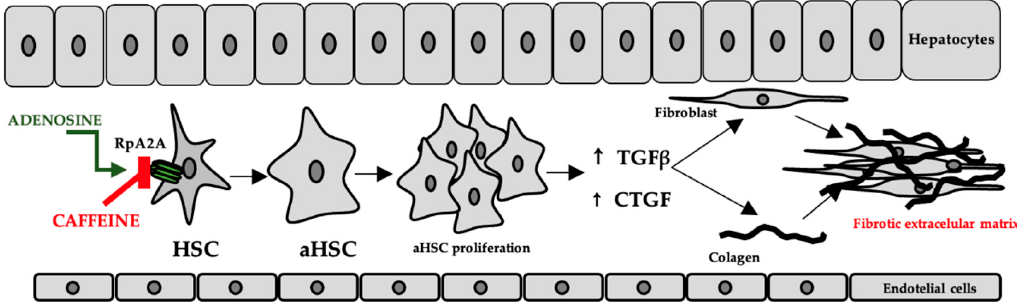
Figure 5. The role of adenosine and caffeine in the occurrence/prevention of liver fibrosis (HSC—hepatic stellate cells, aHSC—activated hepatic stellate cells, TGF β —transforming growth factor beta, CTGF—connective tissue growth factor) .